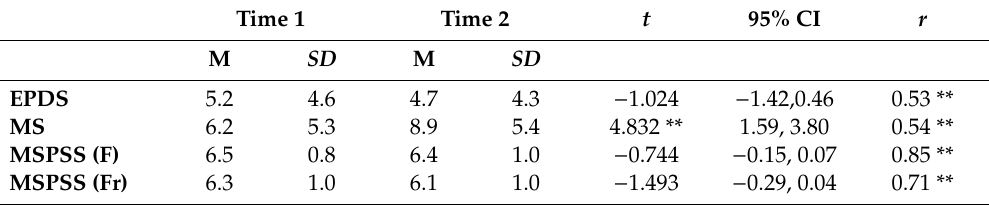
Table 3. Evolution of study outcomes from the second (Time 1) to the third trimester (Time